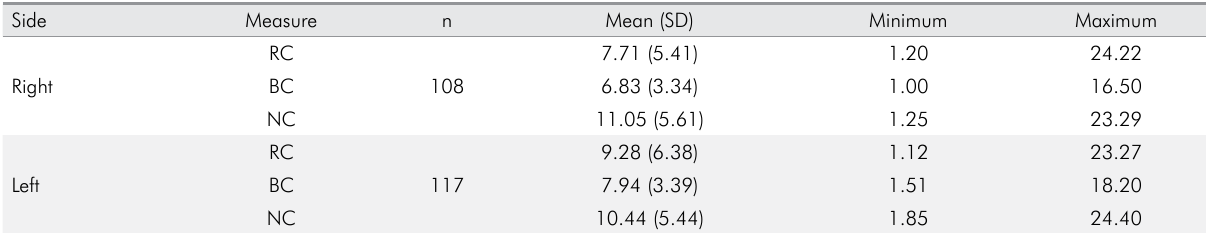
Table 6. Statistical data of the comparisons between the sides for measures RC, BC and NC for the gathered grouped. Side Measure n Mean (SD) Minimum Right